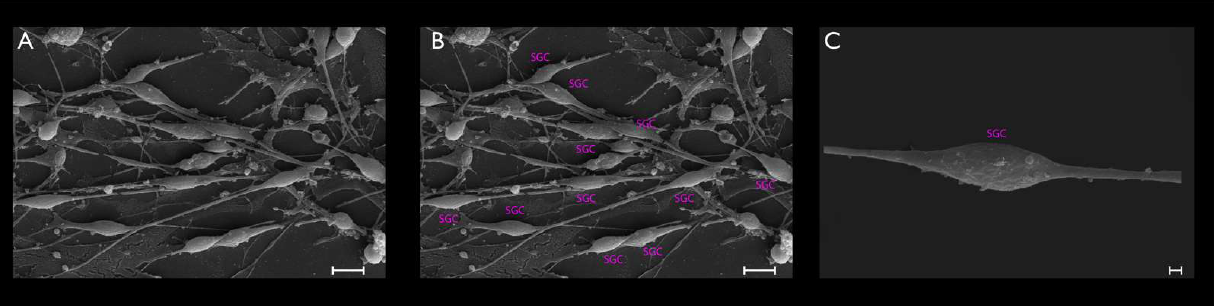
short distances from the TG neurons (pink, B ). Scale bars represent 10 µm.